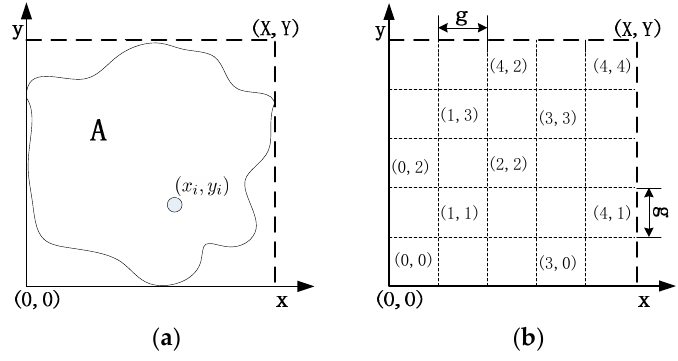
Figure 4. ( a ) Area sketch; and ( b ) network gridding.